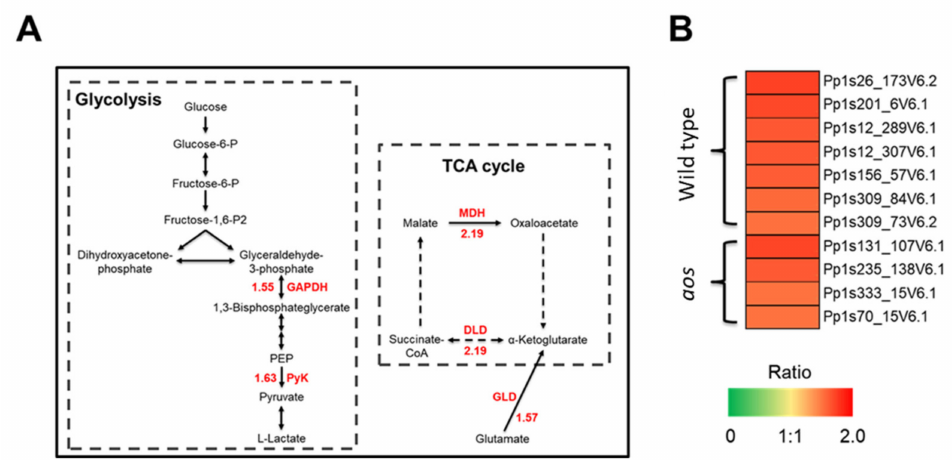
Figure 7. Di ff erentially accumulated proteins involved in glycolysis and the TCA cycle. ( A ) Proteins involved in glycolysis and the TCA cycle were all up-regulated in response to wounding stress in wild-type P. patens . Red numbers represent the relative abundance of proteins related to glycolysis and the TCA cycle in response to wounding in wild-type. GAPDH (Pp1s309_84V6.1, Pp1s309_73V6.2), glyceraldehyde-3-phosphate dehydrogenase; PyK (Pp1s12_289V6.1, Pp1s12_307V6.1), pyruvate kinase; MDH (Pp1s38_300V6.1, Pp1s39_428V6.1, Pp1s79_110V6.1), malate dehydrogenase; DLD (Pp1s98_132V6.1), dihydrolipoamide dehydrogenase; GLD (Pp1s62_236V6.4), glutamate dehydrogenase. ( B ) Heat map representing the profile of di ff erentially accumulated glycolysis and TCA cycle-related proteins induced by wounding in P. patens . Red indicates high accumulation, whereas green indicates low